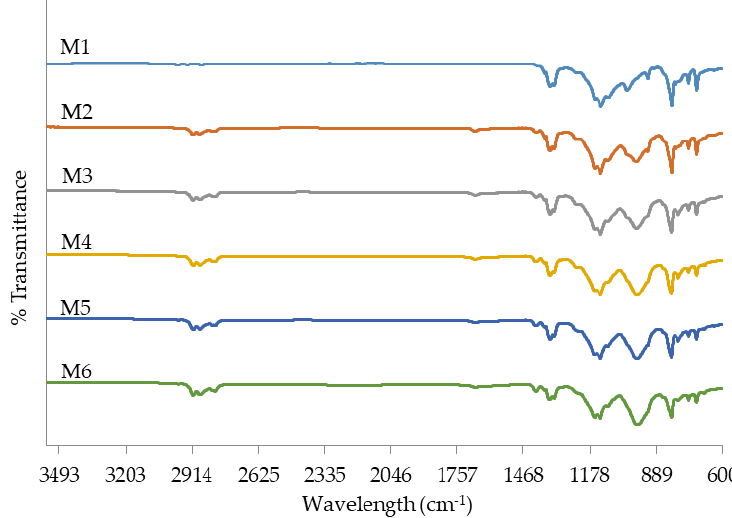
Figure 8. FTIR spectrum analysis on M1, M2, M3, M4, M5 and M6. Table 5. The values of the wavenumbers (cm −1 ) and some significant peaks in the FTIR spectra of the pure B 2 EHP, pure DOP and membranes (M1 and M6).